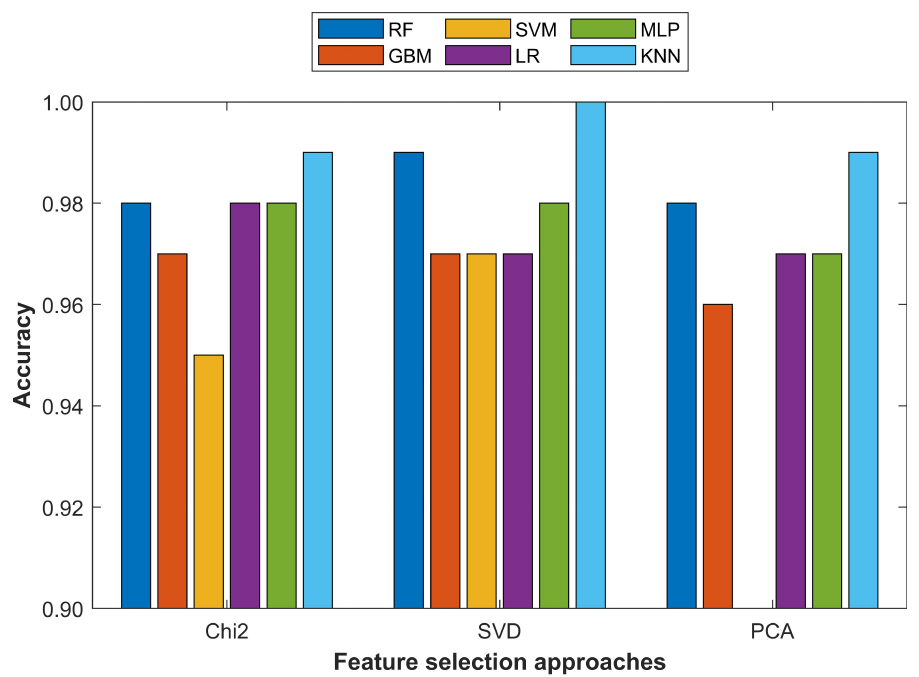
Figure 6. Comparison of different machine learning models with 20 selected features from Chi2, SVD, and PCA